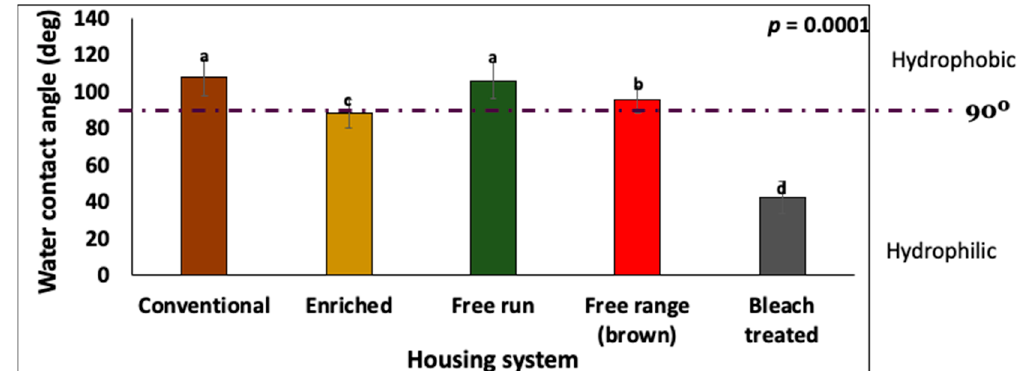
Figure 5. A comparison of the contact angle measurements on the eggshell surface between eggs that were derived from the different housing systems or bleach treated (no cuticle). The values with different superscript letters (Tukey multiple means comparison) are significantly different (ANOVA; p < 0.05). The values represent the mean ± standard deviation ( n = 30).